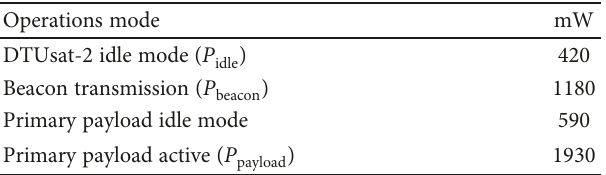
Figure 6: The con fi guration of DTUsat-2 panels. (a) The image shows an unfolded CAD rendering of the six panels. The X and Y panels are used for solar cells, the Z panels are used for the two antenna systems. (b) The image shows an image of DTUsat-2 taken after integration was completed. Table 1: The overall DTUsat-2 power consumption in various modes of operations. When the satellite payload is inactive, the modes will alternate between idle and beacon